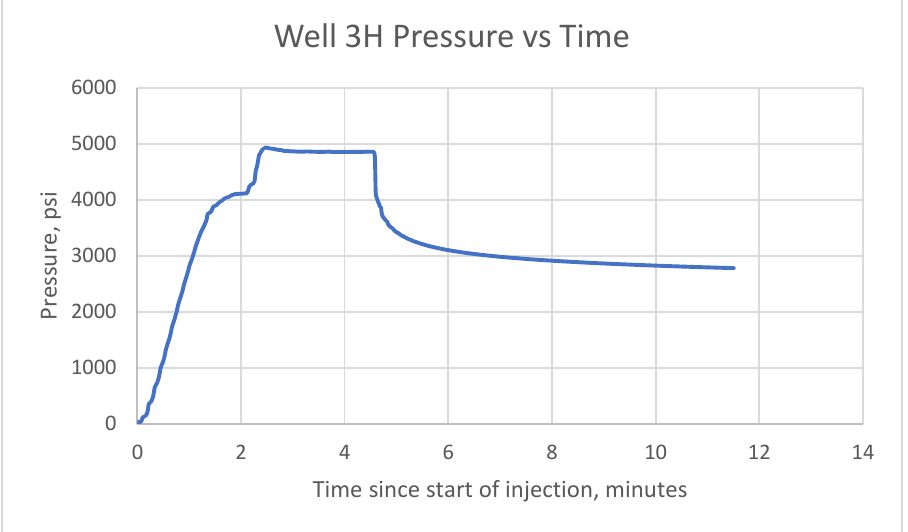
Figure 6. Field DFIT pressure vs. time data for Well 3H at the second injection cycle.